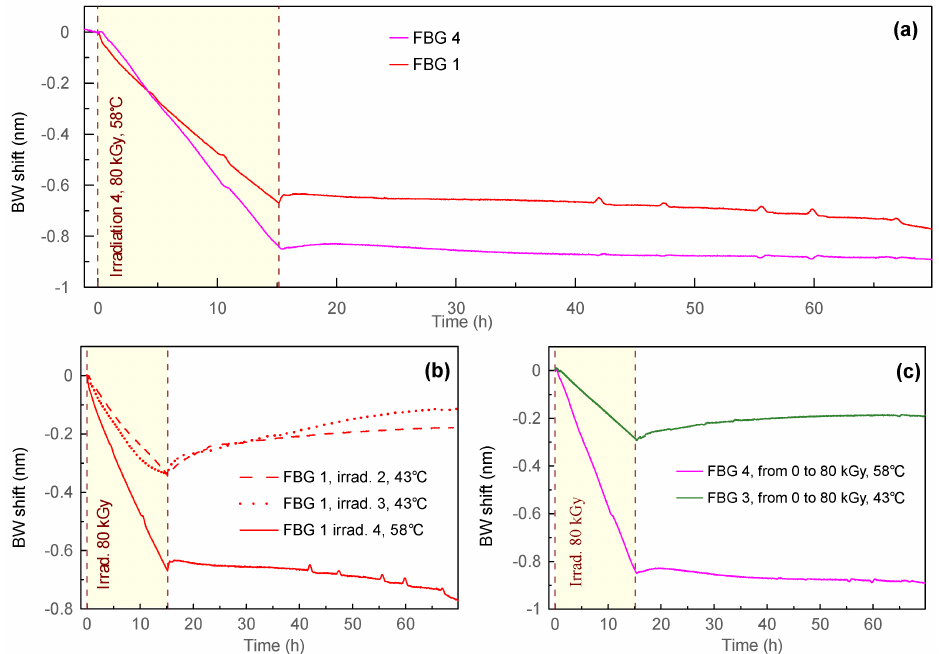
Figure 6. ( a ) The BW evolution during the fourth irradiation session (80 kGy, 58 ◦ C); ( b ) comparison between irradiations 2, 3 and 4 for FBG 1 (time offset was applied to the graph of irradiation 2 to make it start at 0 h); ( c ) comparison of irradiations 3 (FBG 3) and 4 (FBG 4) at 43 ◦ C and 58 ◦ C